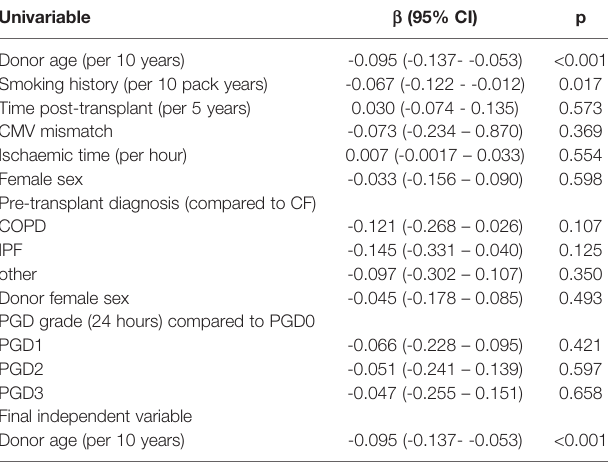
TABLE 2 | Factors associated with bronchiolar telomere length (n = 120).